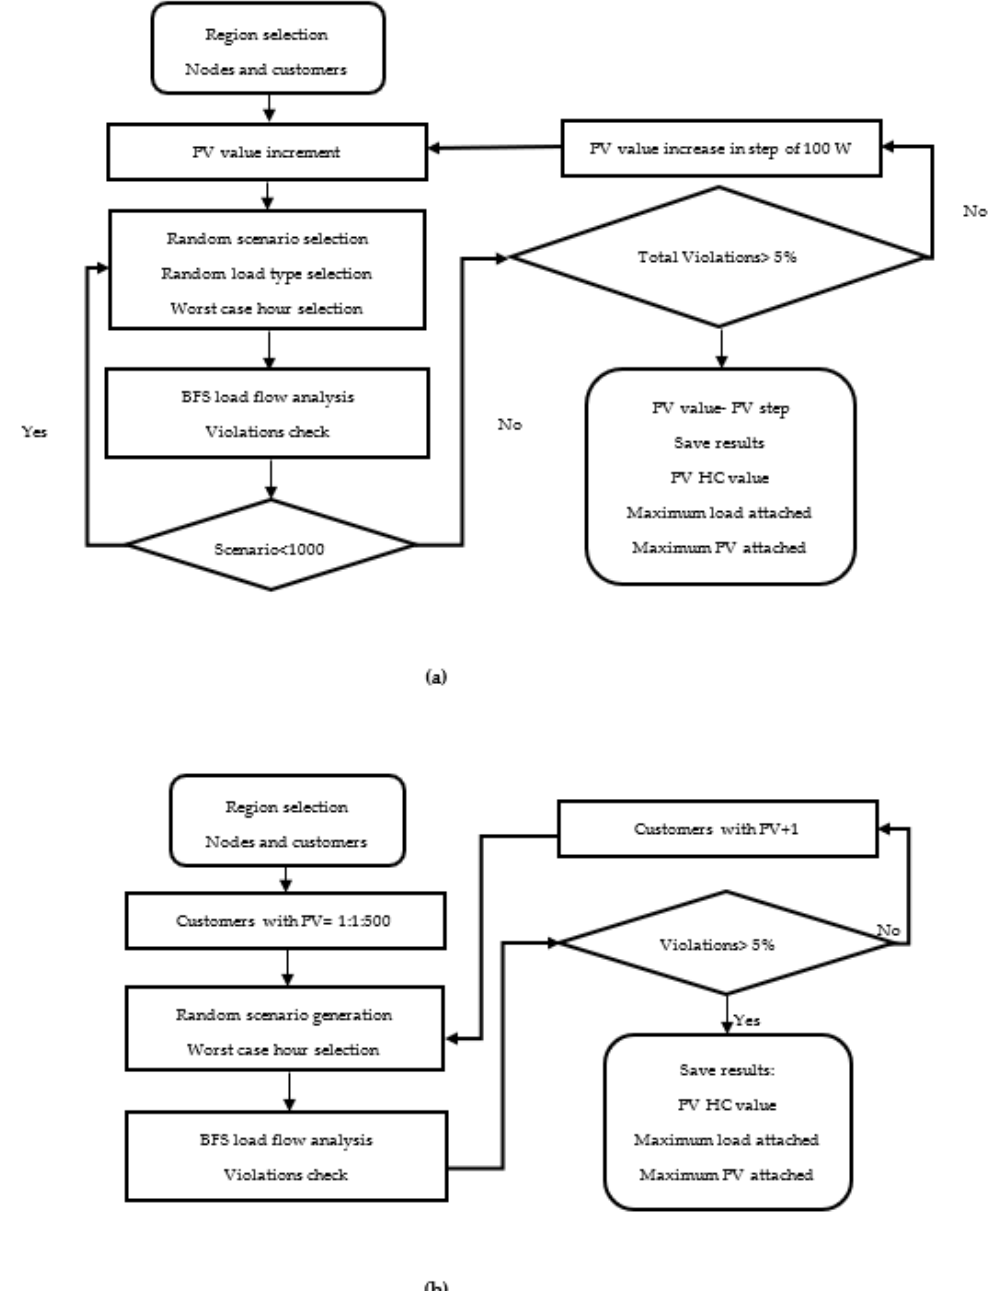
Figure 2. The Monte Carlo (MC) algorithm for the calculation of HC: ( a ) HC w.r.t peak load, transformer rating, energy consumption, and roof-space; ( b ) HC w.r.t customers’ photovoltaics (PVs).